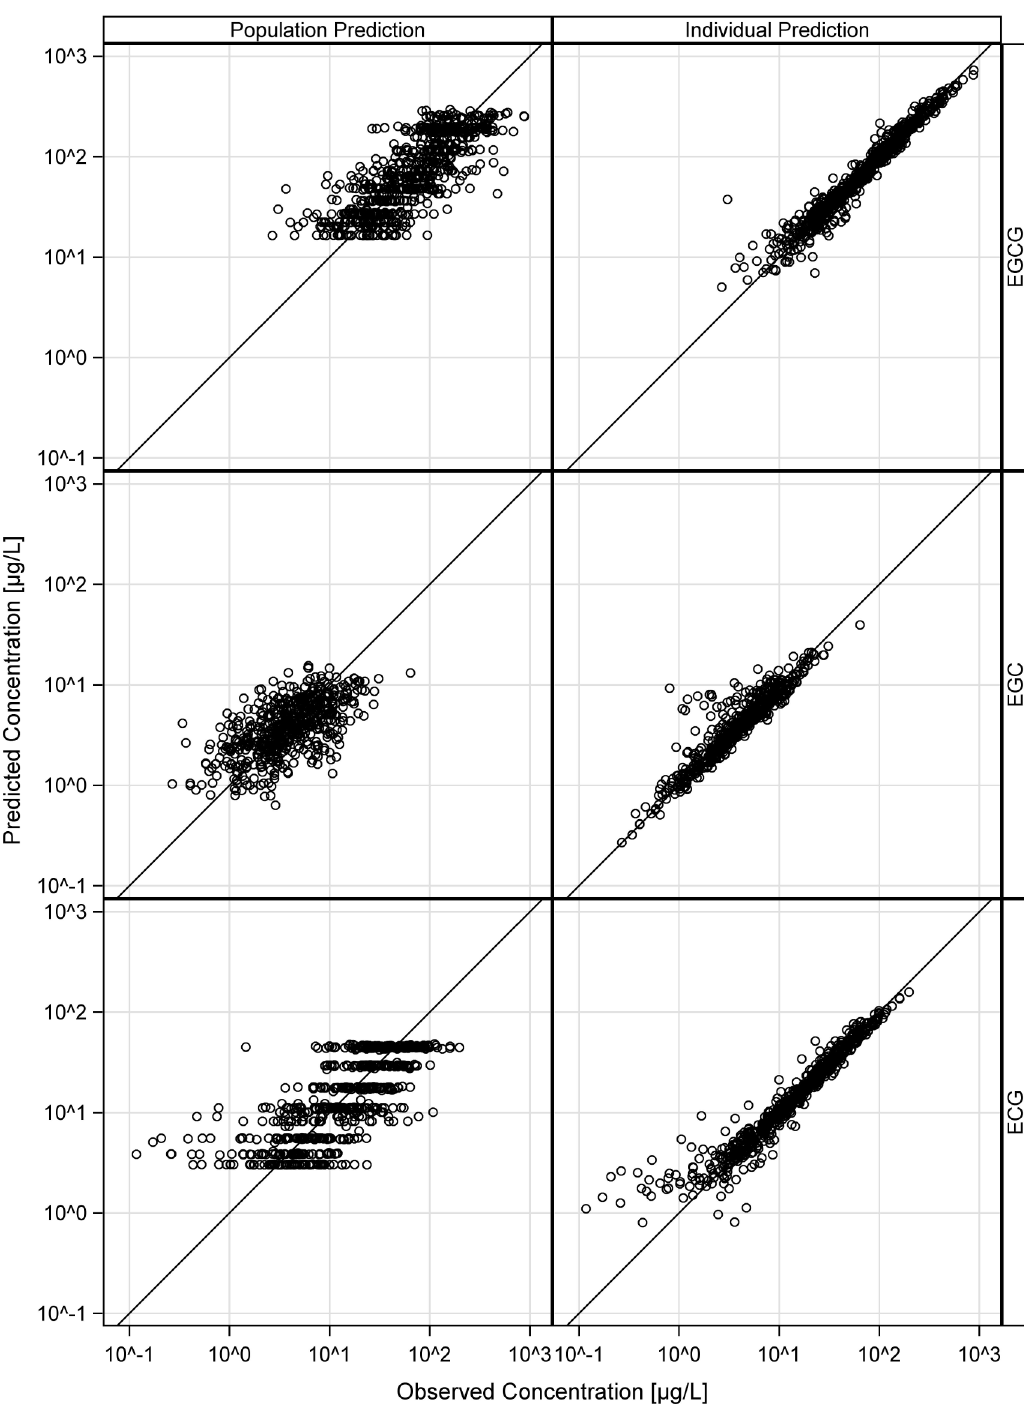
Fig 7. Goodness-of-fit plots of the final PopPK models of EGCG, EGC and ECG. Observed (x-axis) vs. predicted (y-axis) plasma concentrations (black circles) scattered around the line of identity. Population predictions (left panel) and individual plasma concentration predictions (right panel) of all three